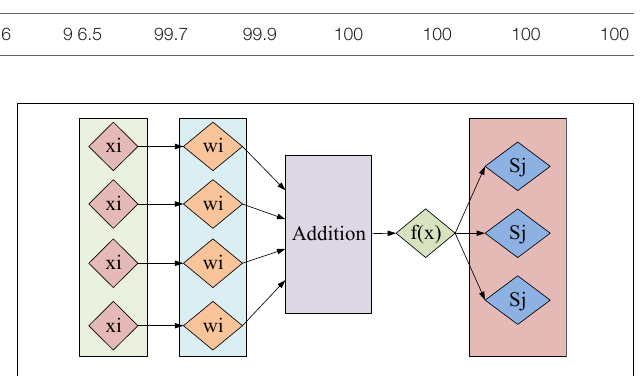
FIGURE 1 | Schematic principle of artificial